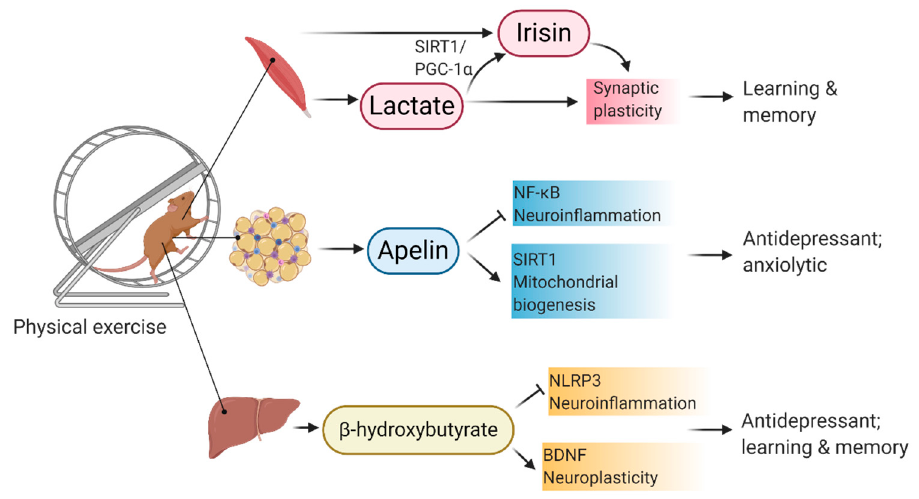
Figure 4. Cytokines secreted from peripheral tissue organs during exercise elicit pro-cognitive effects. The skeletal muscle secrets both lactate and irisin. In particular, both lactate and irisin can separately or concomitantly are engaged in modulating synaptic plasticity in the hippocampus. The adipose tissue secretes apelin, which reduces neuroinflammatory responses and promotes mitochondrial biogenesis in the neurons, respectively. The liver secretes β -hydroxybutyrate, a natural NLRP3 inhibitor, which can suppress the neuroinflammatory response. β -hydroxybutyrate can also promote neuroplasticity alongside with upregulating BDNF expression in the hippocampus. These exerkines are shown to be pro- cognitive by modulating both mood-related behaviours and learning and memory performance in the rodent studies. Created with